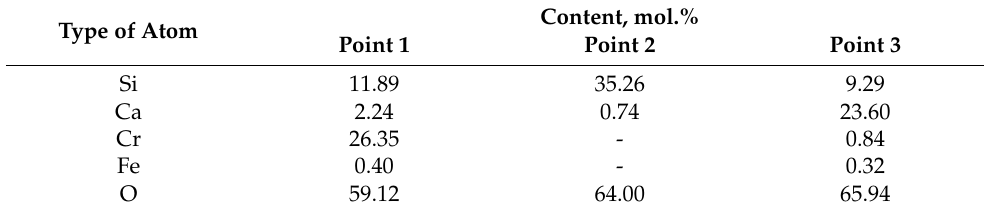
Figure 7. Choice of points for EDXS of heat-treated sealant–steel assembly. Table 1. Elemental composition in the points shown in Figure